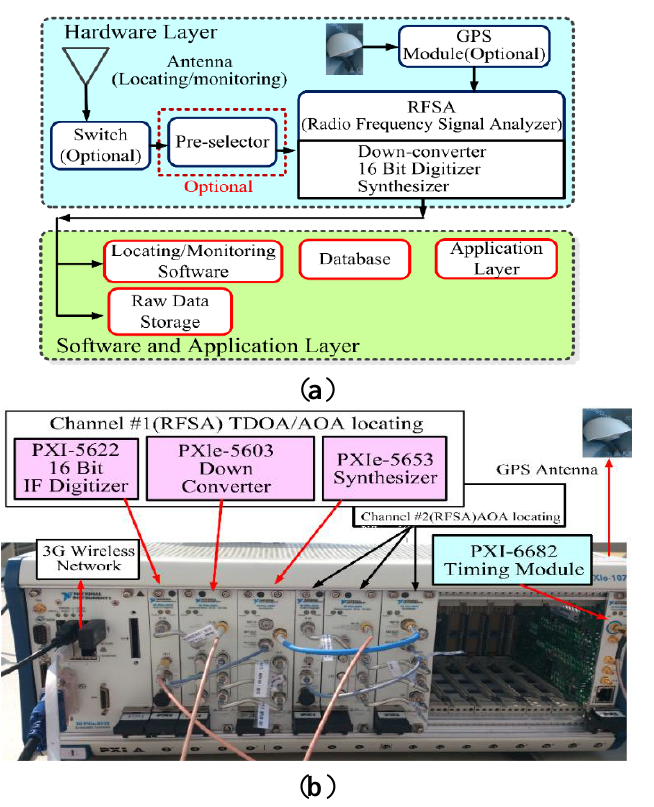
Figure 2. The proposed TDOA monitoring/locating system ( a ) system architecture ( b ) physical configuration in current